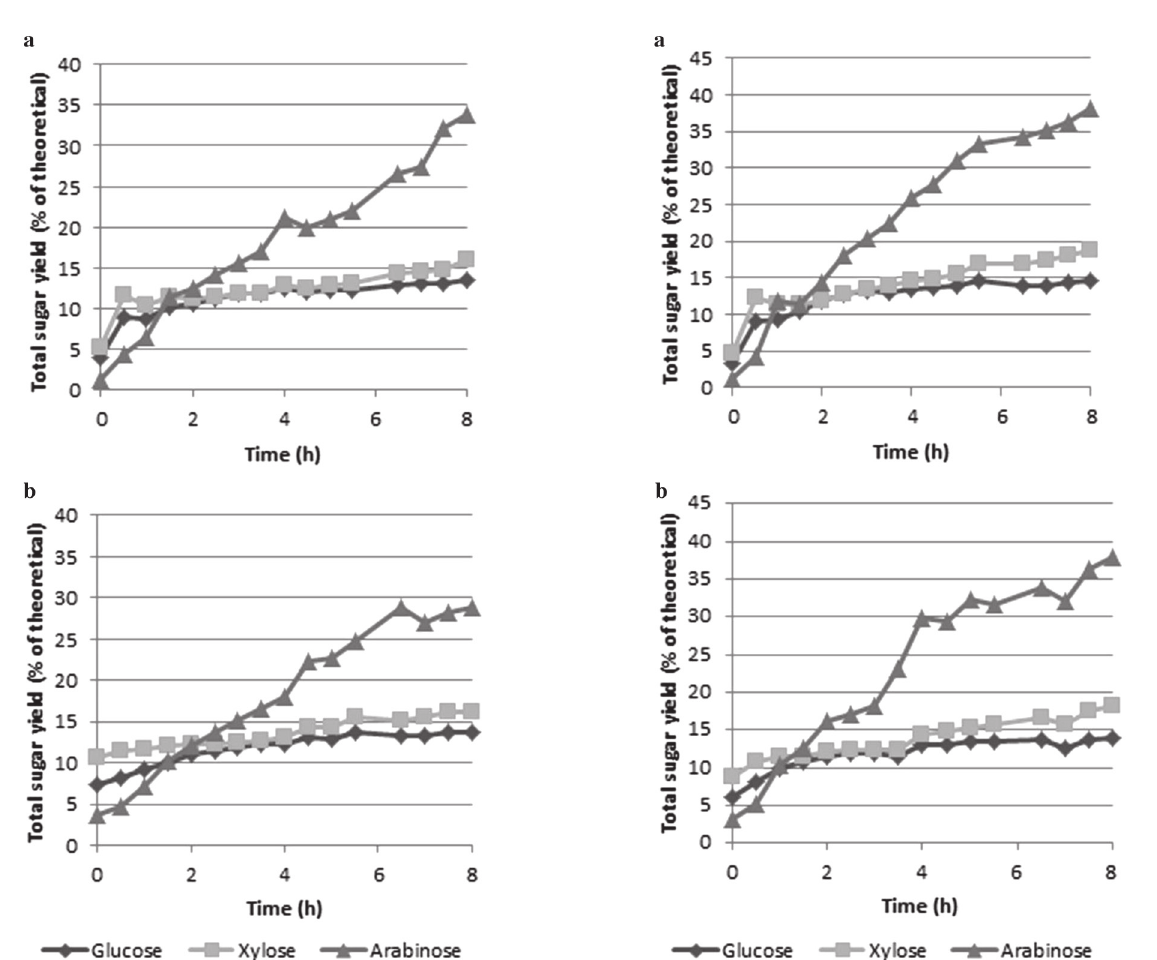
Fig. 2 – Arabinose removing pre-hydrolysis at 90 °C and 7 % (w/w) dry matter using 0.25 % (w/w) sulfuric acid (a), and arabinose removing pre-hydrolysis at 90 °C and 7 % (w/w) dry matter using 0.25 % (w/w) sulfuric acid after 24 hours soaking of the raw material in the acidic liquid (b)